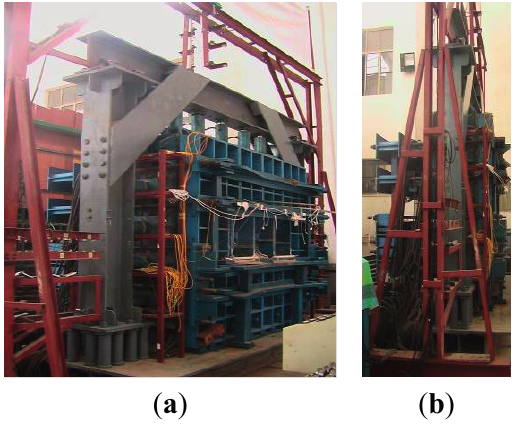
Figure 7. The 3D steel frame structure for the physical model test. ( a ) A front view; ( b ) A side